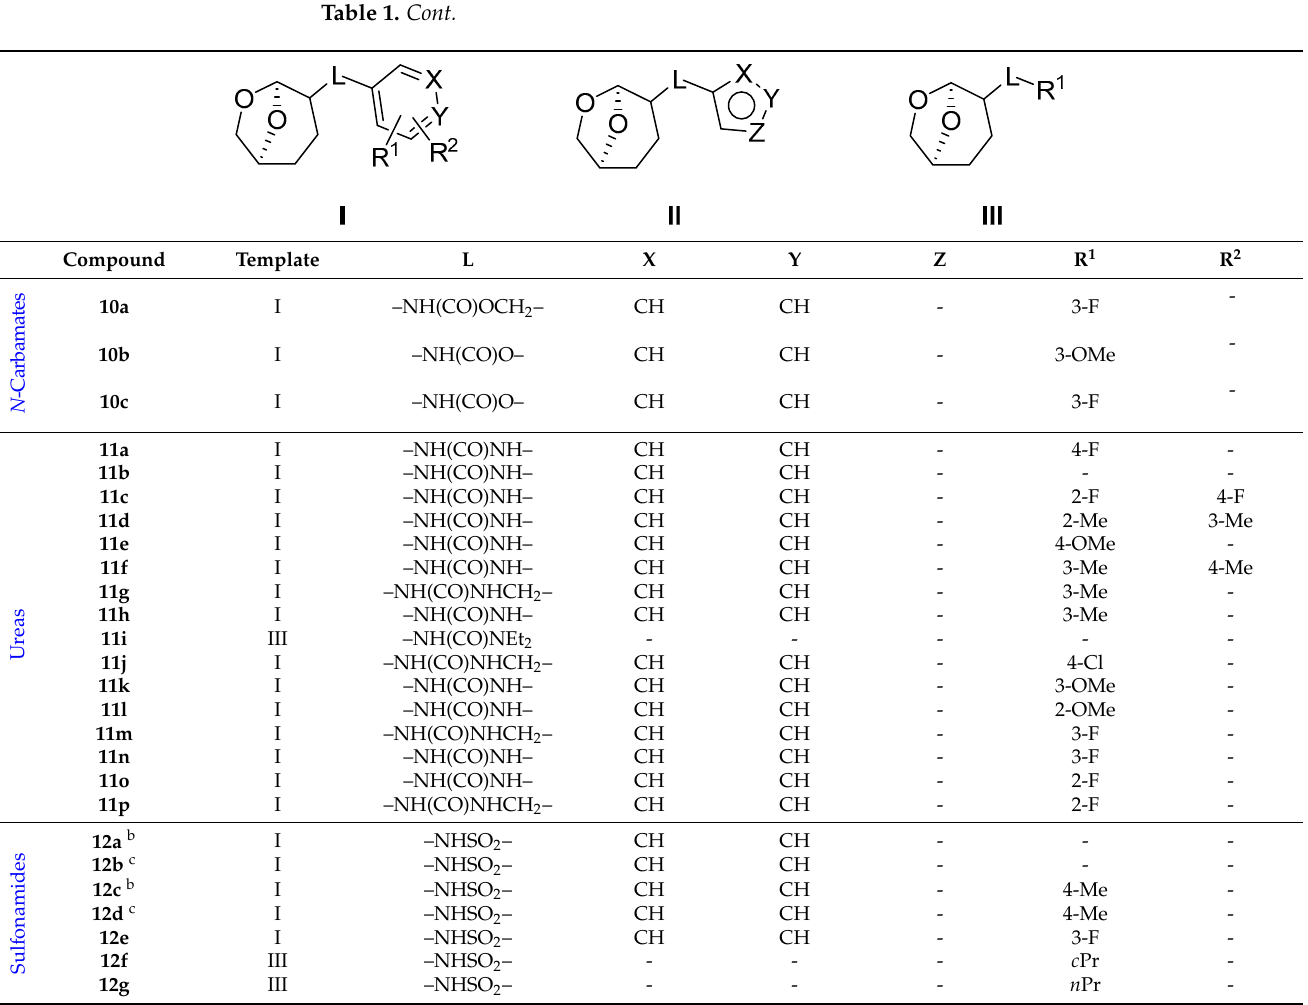
Table 1. All 100 compounds prepared in this study. Three templates (I, II, III) are used for clarity. Unless mentioned otherwise, compounds are a mixture of endo and exo diastereomers. Supplemen- tary Materials Tables S2 and S3 show all full structures, d.r. values and, where appropriate, pro- Table 1. Cont. posed relative stereochemistry of the (major)